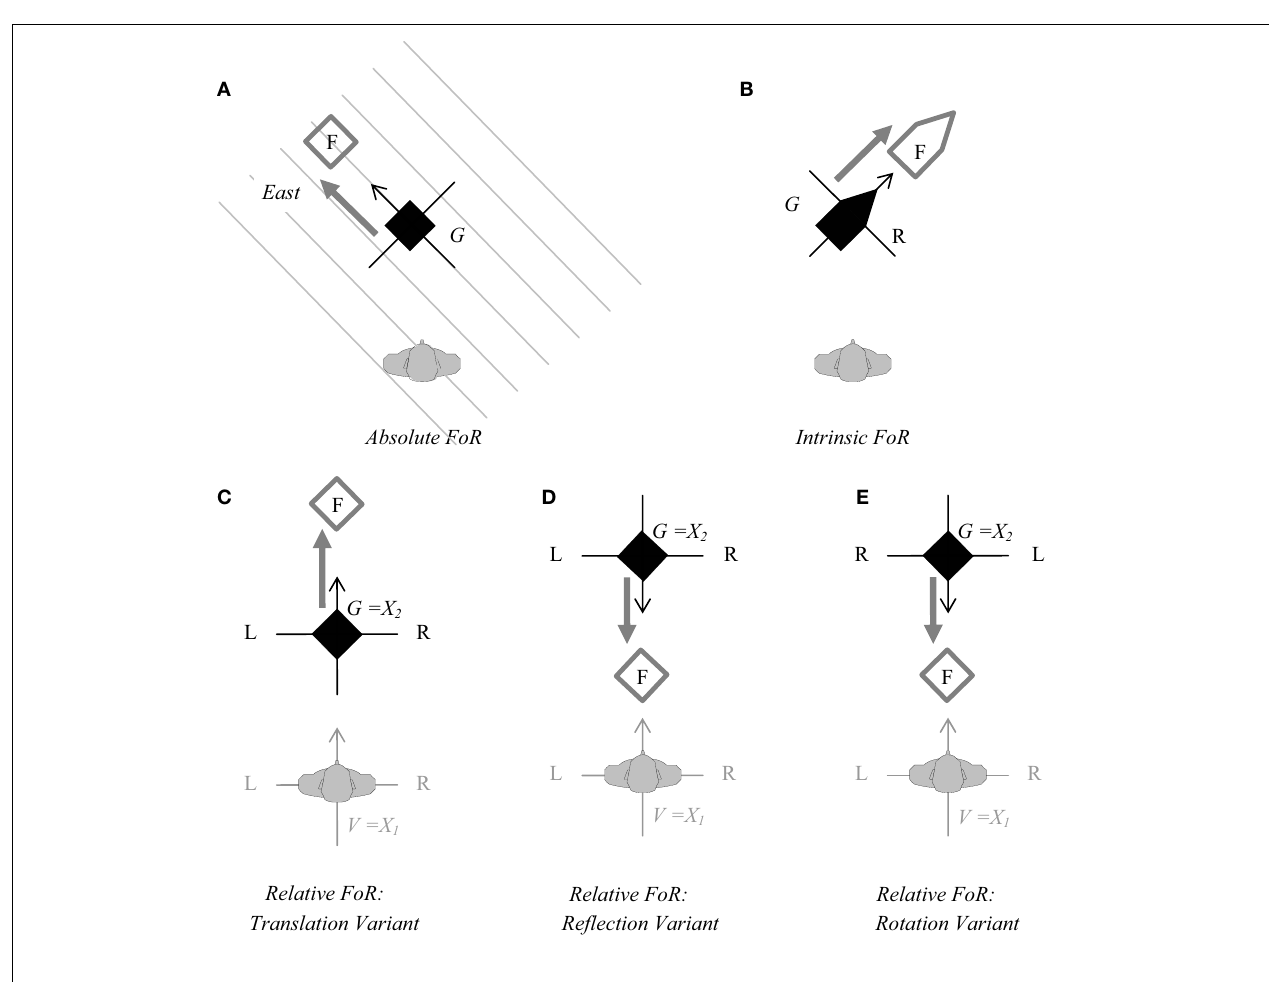
the movement of F from is original position G to the new position. Left is indicated by L, right by R, the origo of the coordinate systems by X , and their (acquired) FRONT by the tip of the thin arrow. In the relative FoRs, the primary coordinate system ( X 1 ) originates in Ego, the secondary coordinate system (origo X 2 = G) is obtained (C) by translation into G, (D) by reflection in G, or (E) by rotation in